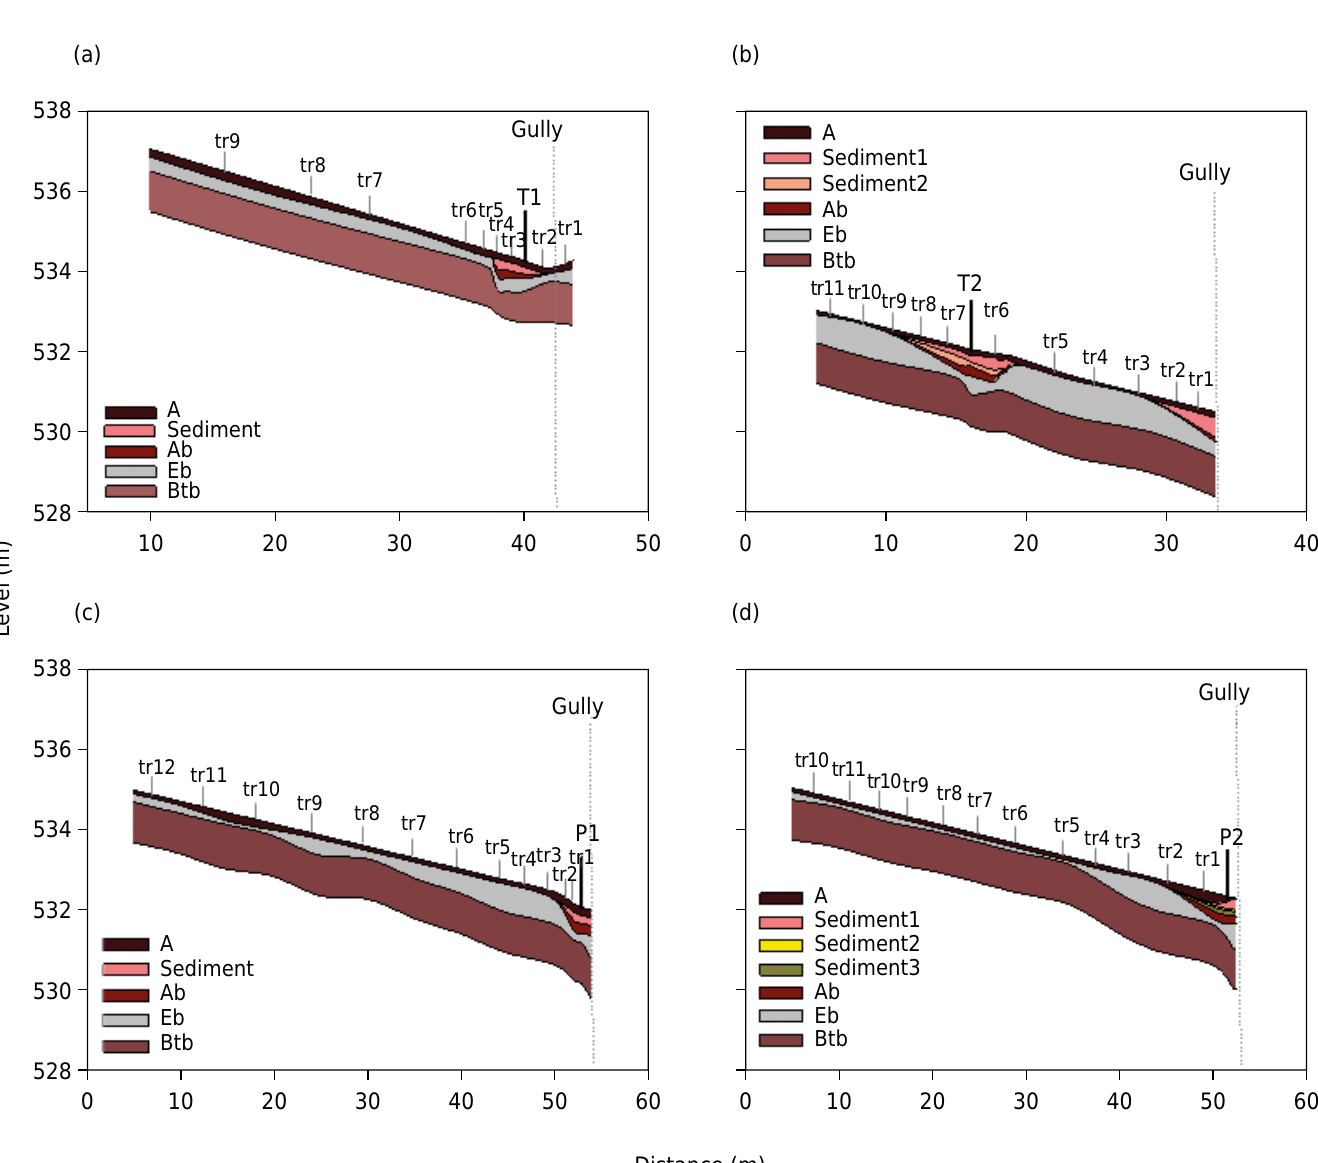
Figure 5. Structural analysis and two-dimensional distribution of TP1 segments (a), TP2 (b), TP3 (c), and TP4